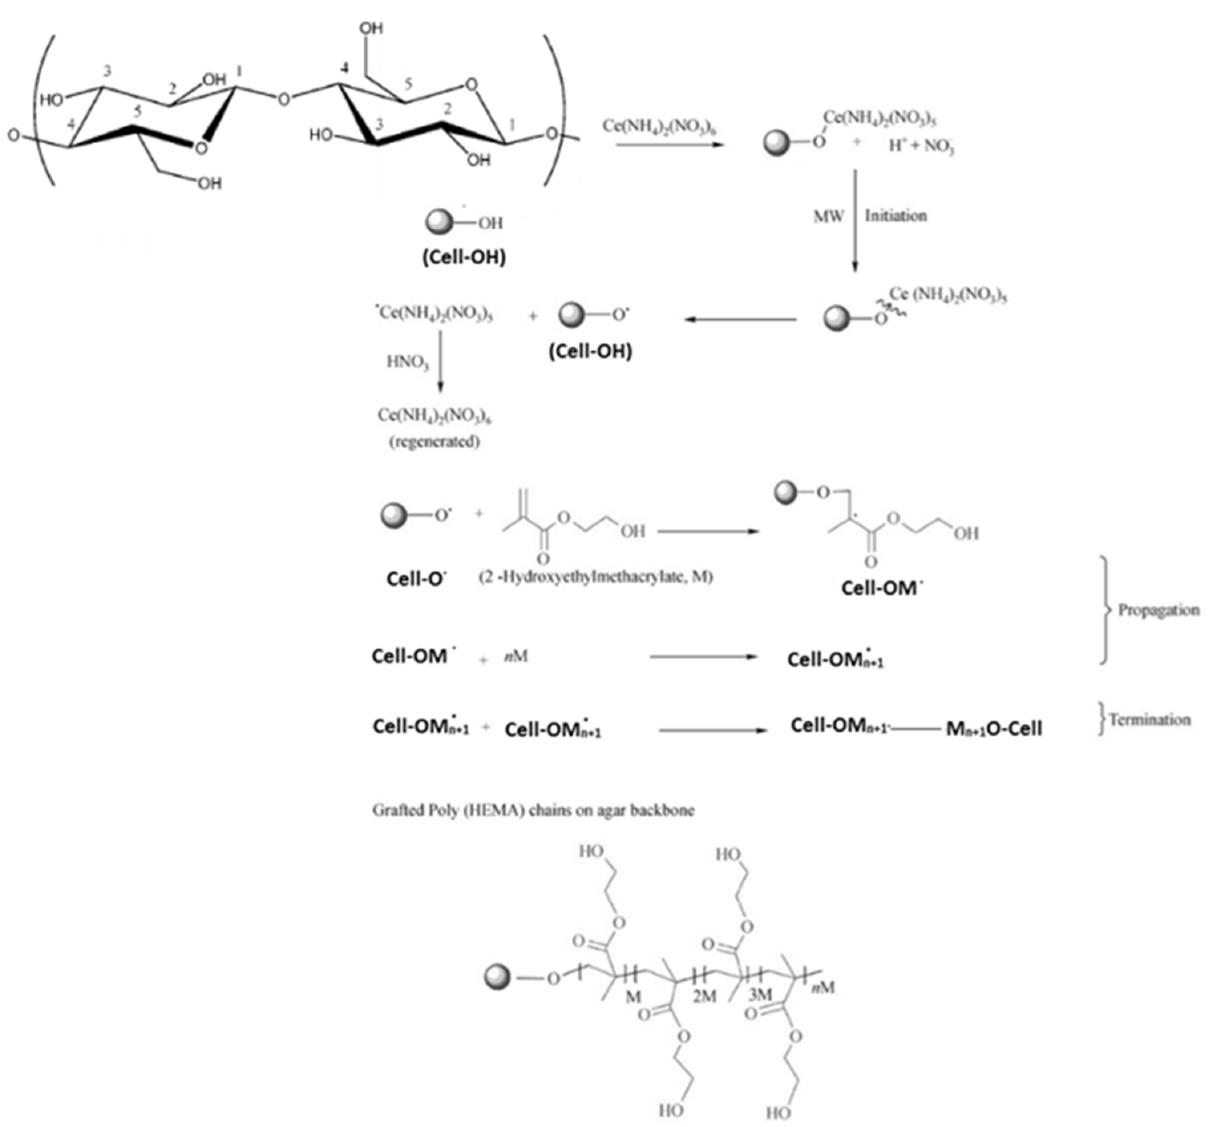
Figure 1. Grafting of 2-hydroxyethyl methacrylate (HEMA) onto cellulose using different microwave irradiation time ( a ), monomer concentrations ( b ) and ceric ammonium nitrate (CAN) concentration ( c ).